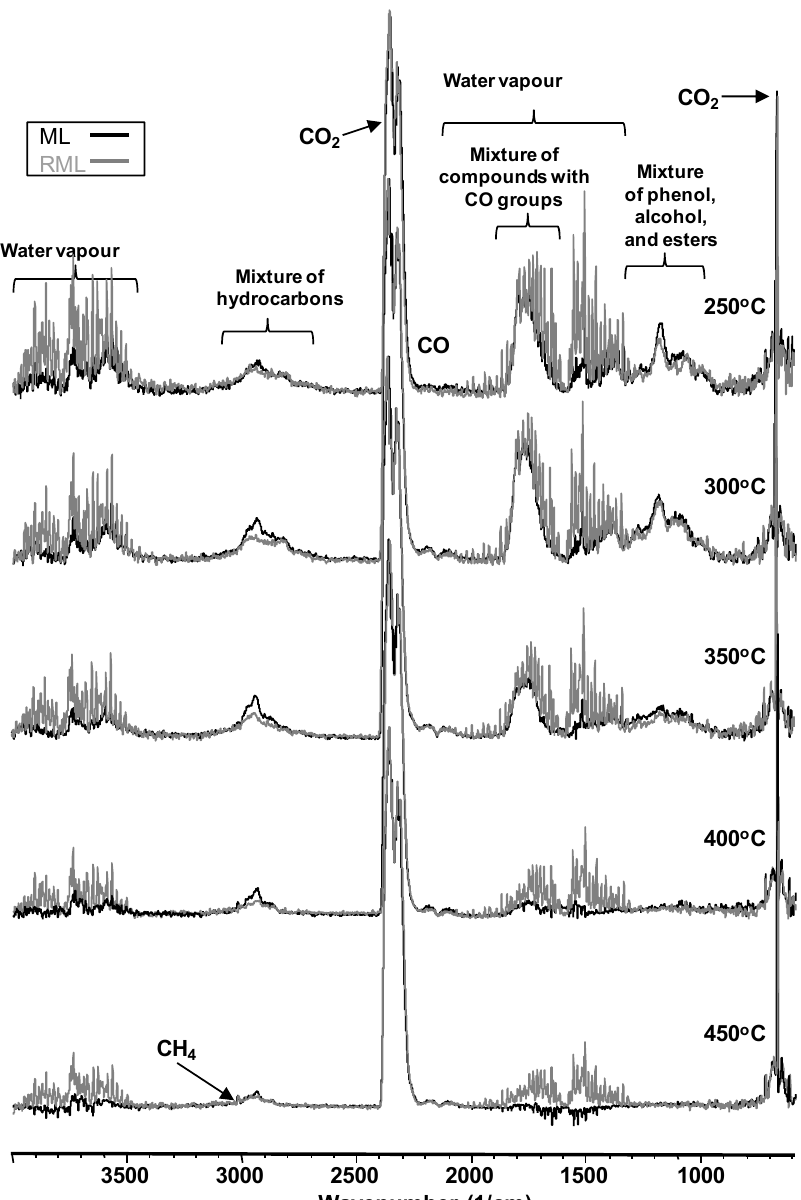
Figure 11. FT-IR spectra of volatile products emitted during pyrolysis of ML and RML samples.